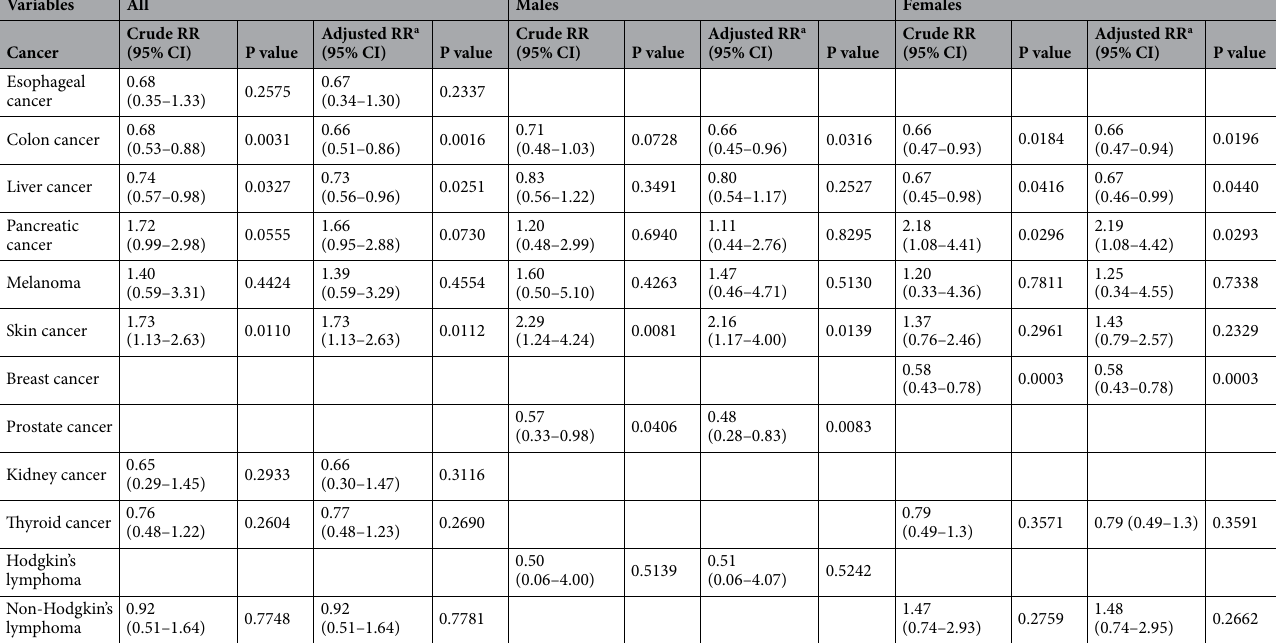
Table 4. Relative risk of specific cancers in patients with keloids, stratified by gender. RR relative risk, 95% CI 95% confidence interval. a Model adjusted for age group, gender, and the residential region using a Cox proportional-hazards regression model.